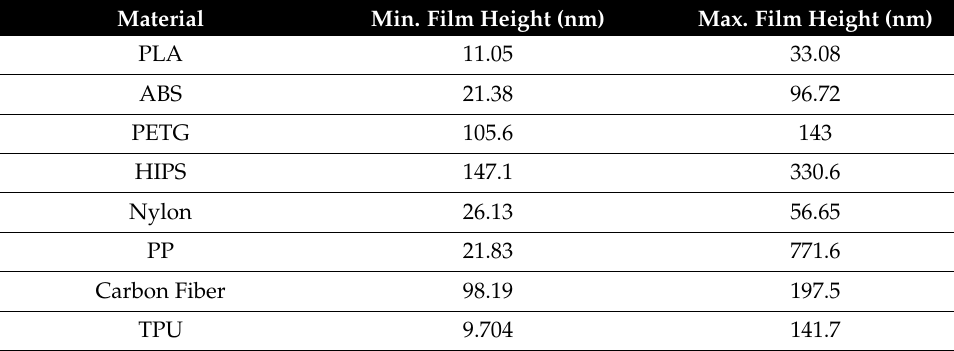
Table 3. Region 1 nanoparticle film